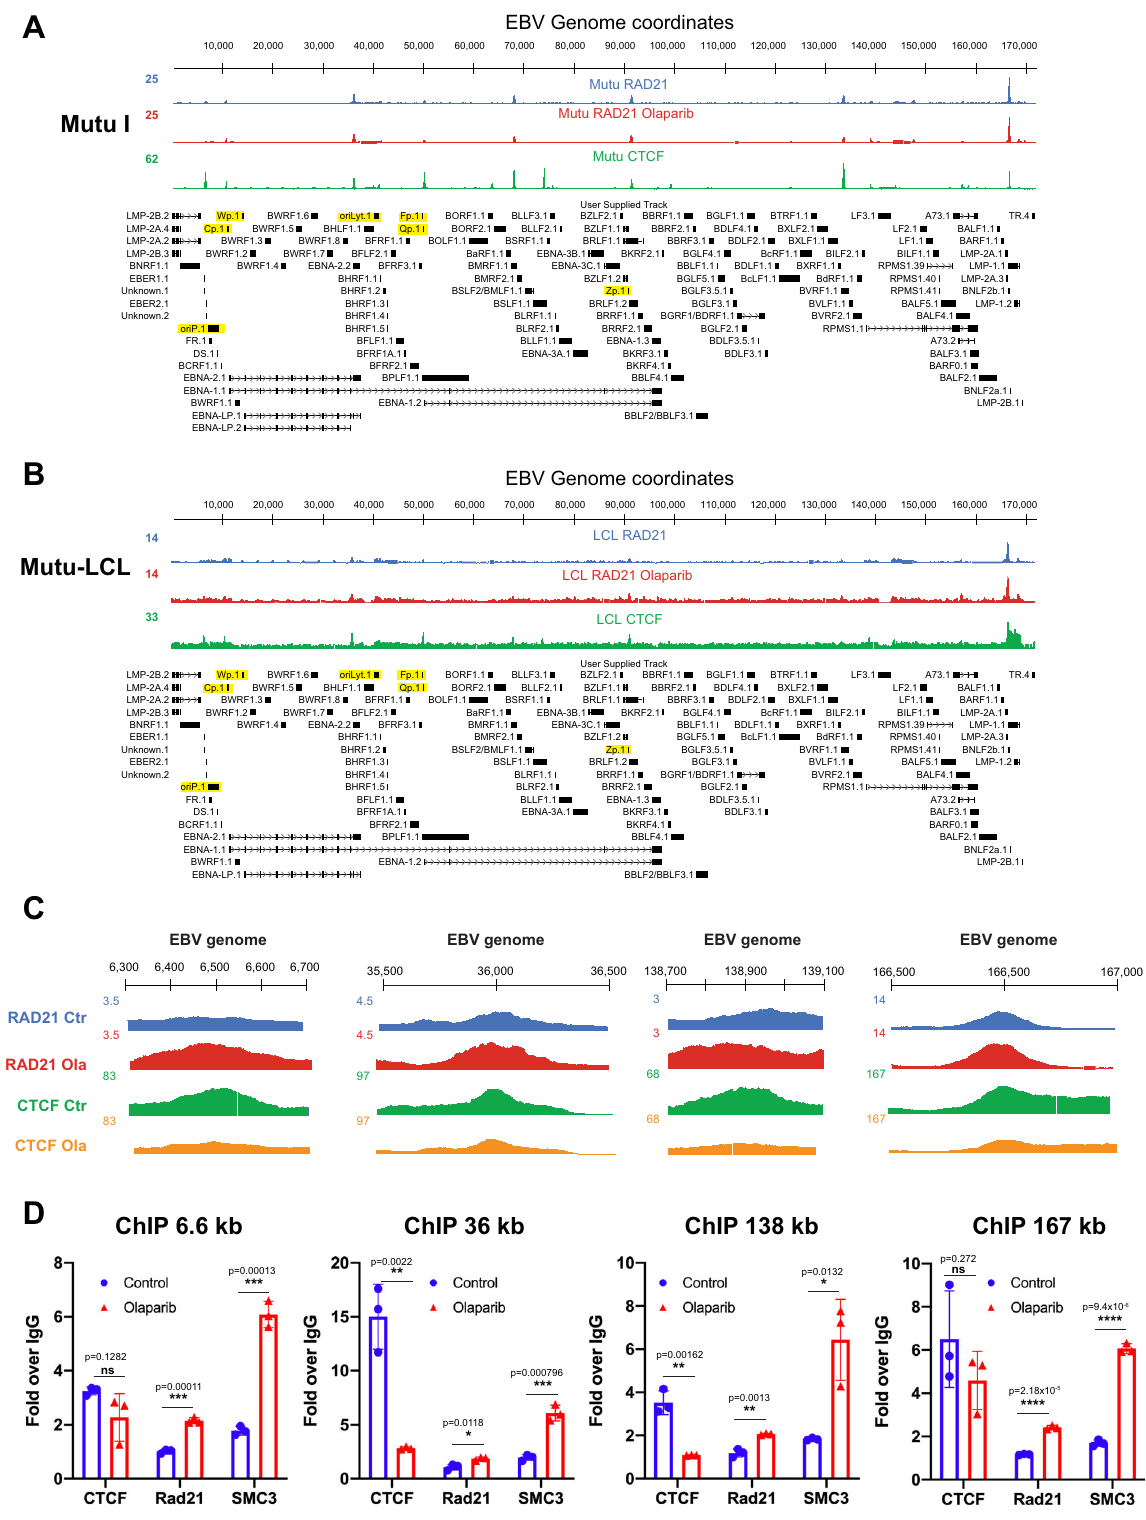
Fig. 3 Cohesin – chromatin binding frequency is increased after PARP inhibition. A ChIP-seq tracks for CTCF (green), RAD21 (cohesin component, blue), and RAD21 after PARP inhibition (cohesin component, red) in type I EBV latency cell line Mutu. All ChIP-seq tracks are normalized to input chromatin and aligned to the EBV genome. B ChIP-seq tracks (as described in ( A )) in type III latency EBV cell line LCL. C Magni fi ed RAD21 binding pro fi les in LCL, before (blue) or after PARP inhibition (red), aligned to CTCF binding pro fi les before (green) or after PARP inhibition (orange) in the same cell line. D ChIP-qPCR validation of magni fi ed regions of LCL ChIP-seq tracks for cohesin (RAD21, SMC3) and CTCF, normalized to input chromatin and fold change over IgG. Source data are provided as a Source Data fi le. Values are averaged from three independent assays ( N = 3, mean ± SD). Groups were compared by paired student ’ s t test assuming equal variance (two-tailed). (* = p ≤ 0.05, ** = p ≤ 0.01, *** = p ≤